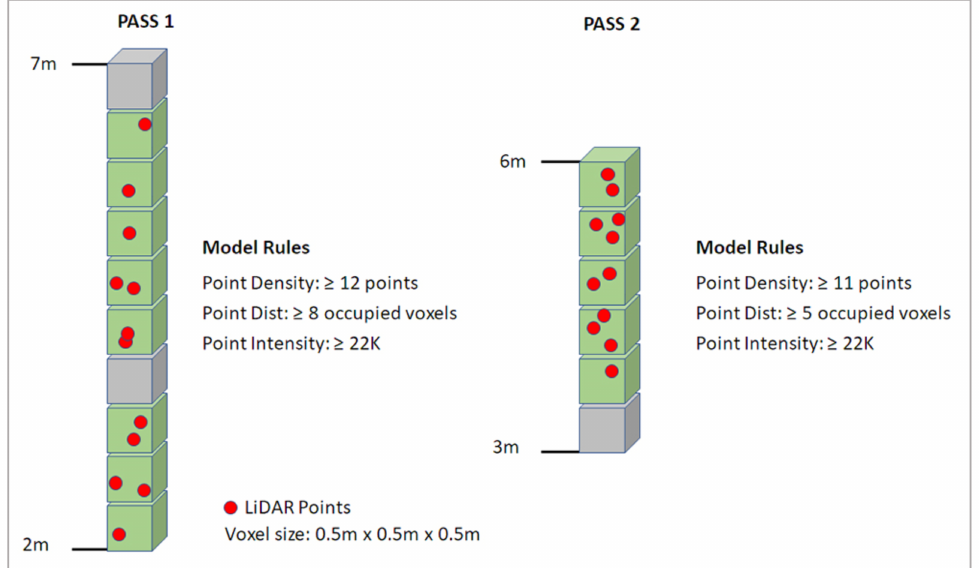
Figure 9. Visual summary of logic and rules for the two-pass voxel-based approach of identifying predicted tree locations from voxel columns.